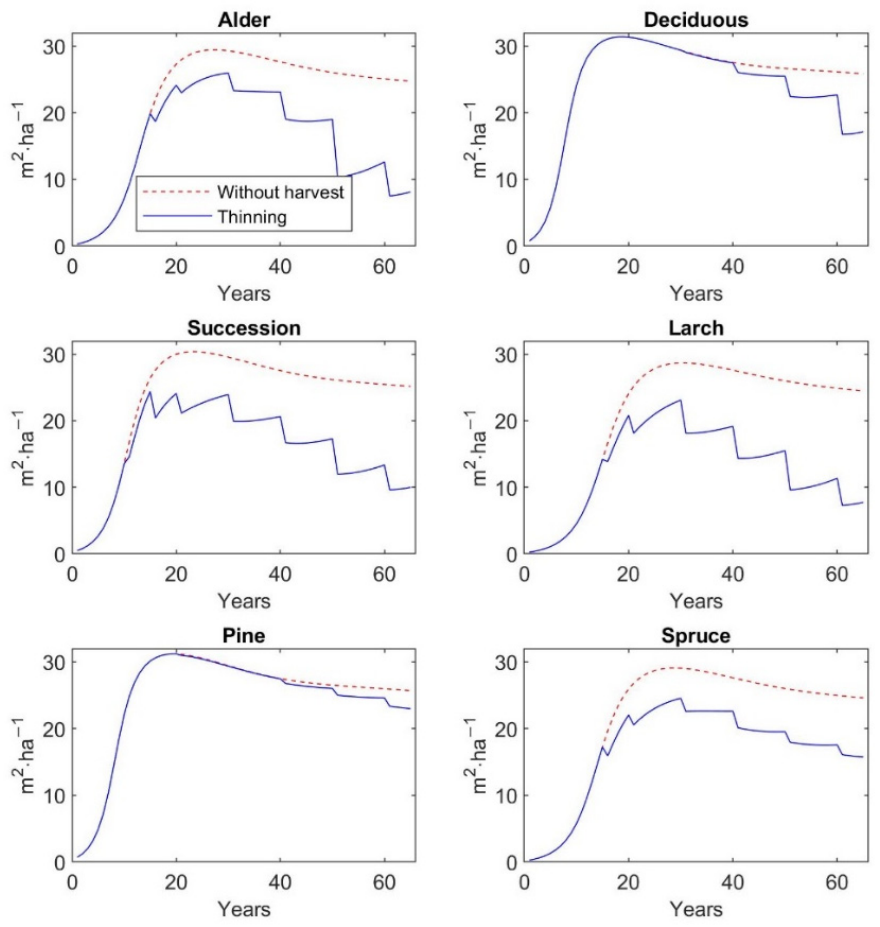
Figure A5. Predicted basal area over 65 years without harvest and under different thinning regimes and forest types.